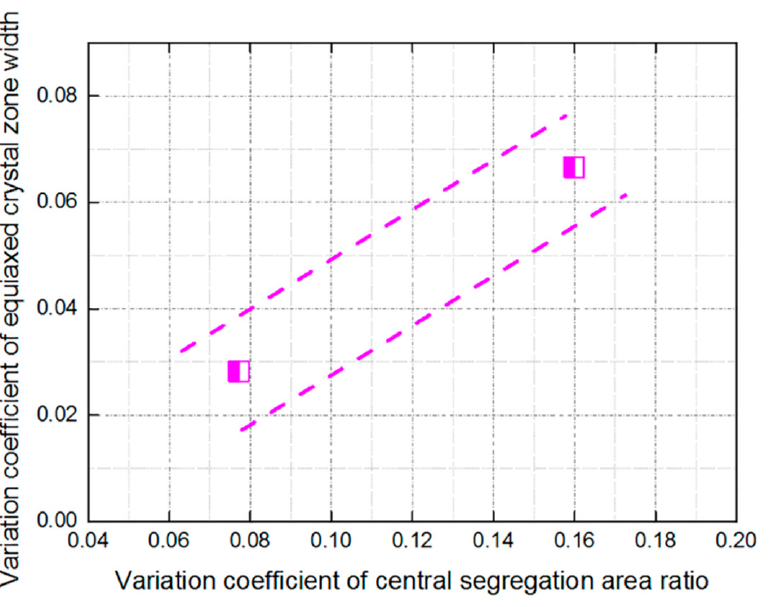
Figure 5. Fluctuation characteristics of solidification structure and central segregation of billet No. 1 and No. 2.